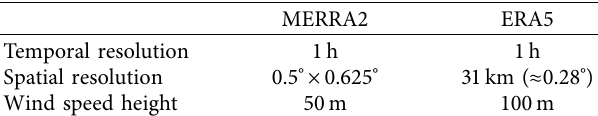
Table 2: Characteristics of MERRA2 and ERA5.